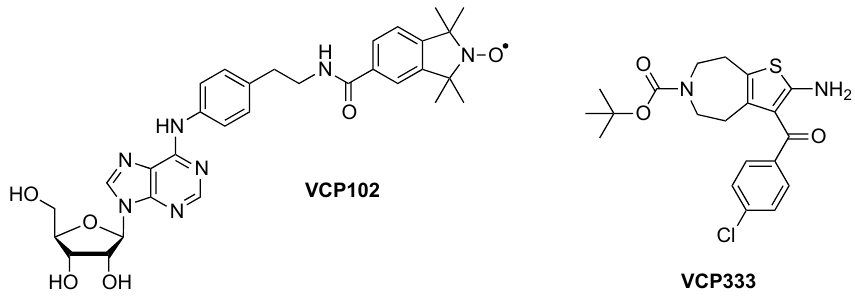
Figure 1. Chemical structures of VCP102 and